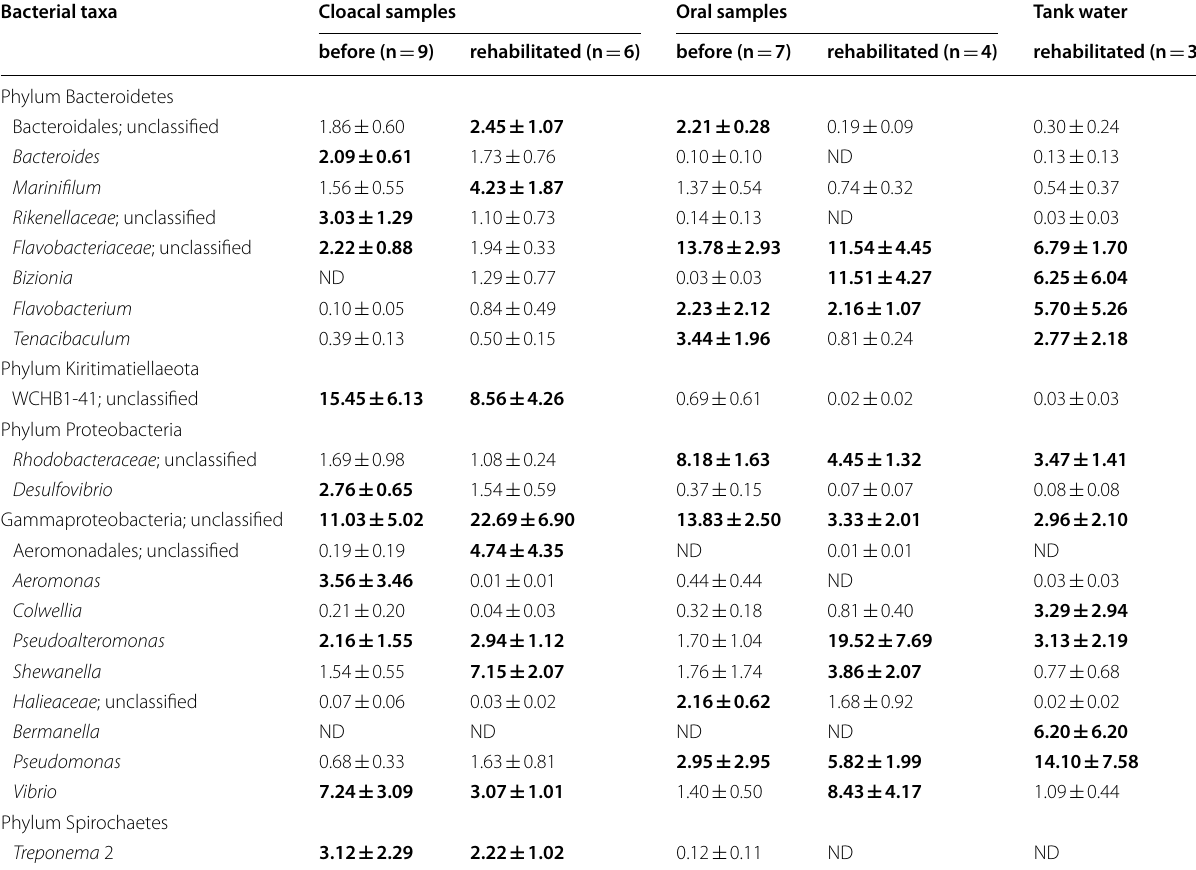
Table 3 Bacterial taxa of loggerhead sea turtle cloacal and oral, and tank water samples classified to the genus (or higher